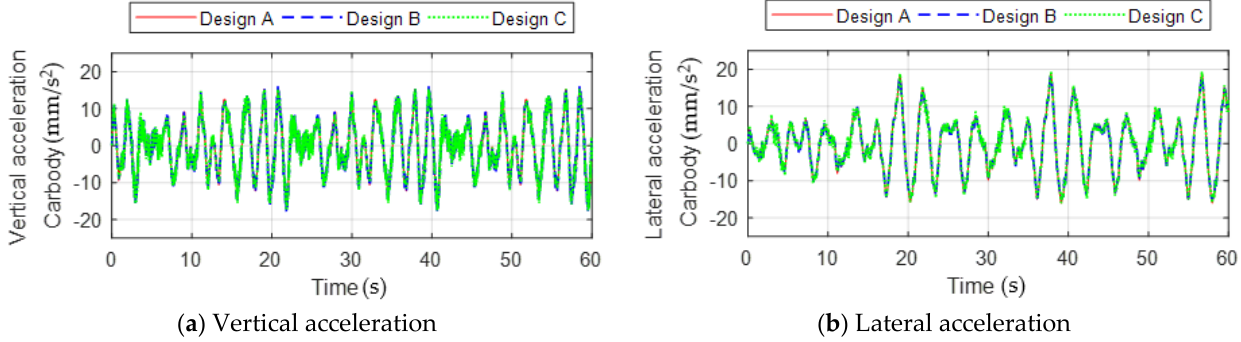
Figure 23. Vertical and lateral accelerations of the carbody at a speed of 600 km/h.